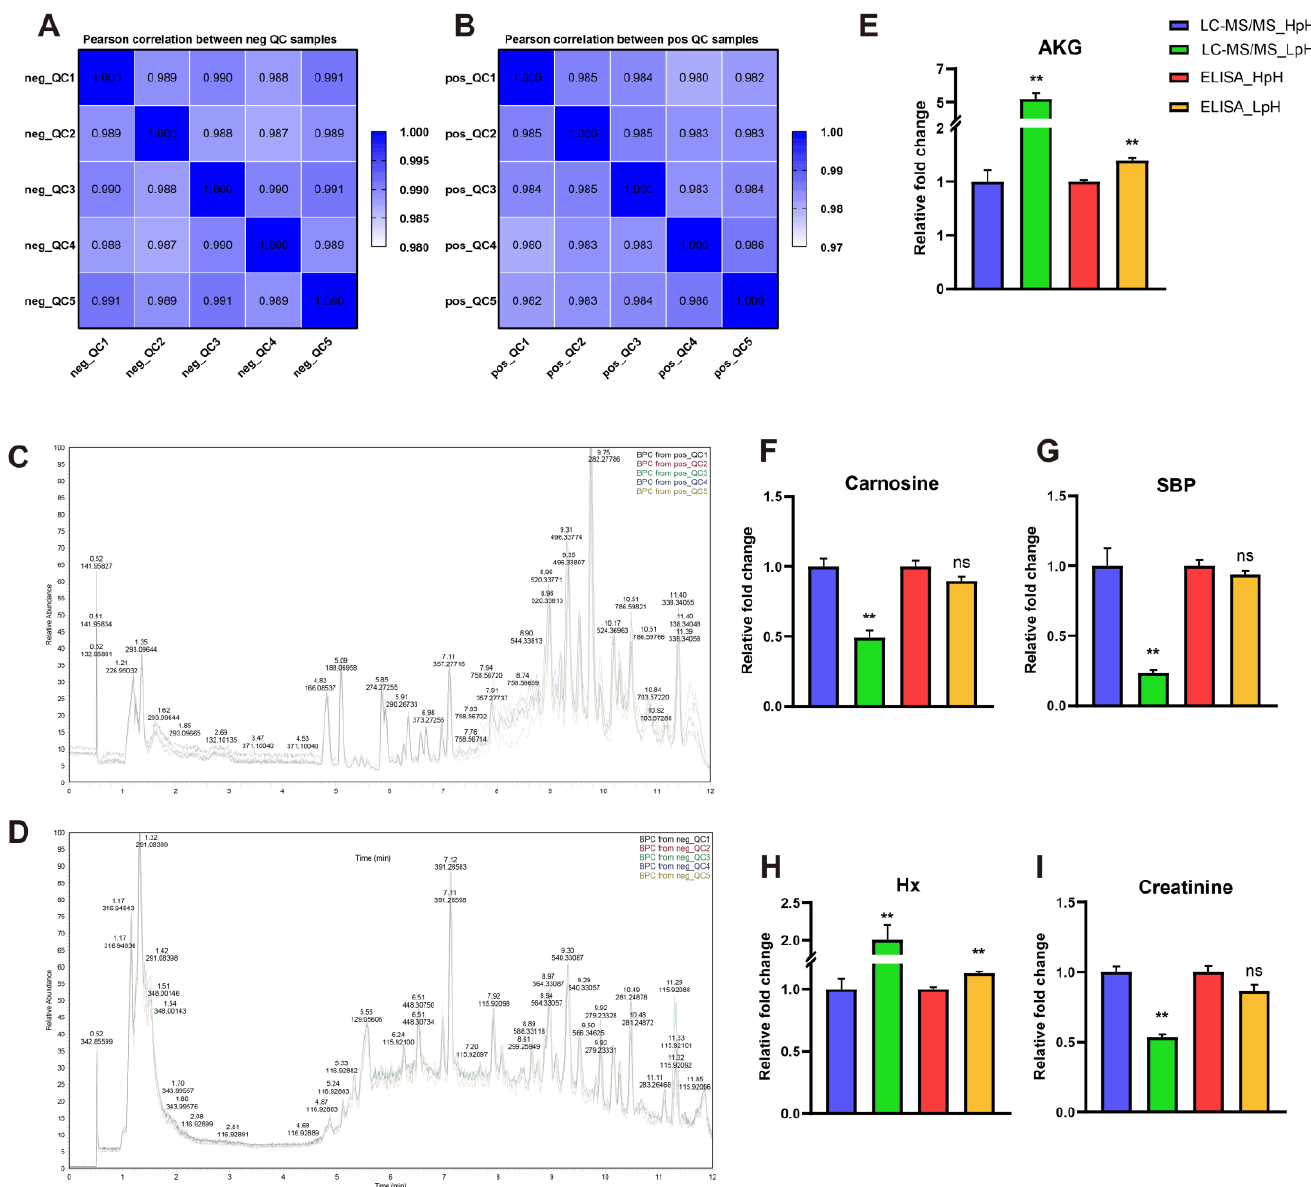
Figure 3. Quality control (QC) of metabolomics analysis based on ultra-high-performance liquid chromatography coupled with mass spectrometry (UHPLC-MS/MS). Heatmap of correlation be- tween base peak intensity chromatograms of QC samples in positive ( A ) or negative ( B ) ion modes. Base peak chromatogram (BPC) of QC samples in positive ( C ) or negative ( D ) ion modes. Relative fold changes of several metabolites in the plasma of porcine muscle with high pH (HpH) and low pH (LpH) using ultra-high-performance liquid chromatography coupled with mass spectrometry (UHPLC-MS/MS) or immunoassay (ELISA). ( E ) Alpha ketoglutaric acid (AKG); ( F ) carnosine; ( G ) sedoheptulose 1,7-bisphosphate (SBP); (H) hypoxanthine (Hx); ( I ) creatinine. The results are pre- sented as means ± SEM (n = 10). Significant differences were determined by unpaired t -test (ns: no significant difference, ** p < 0.01).